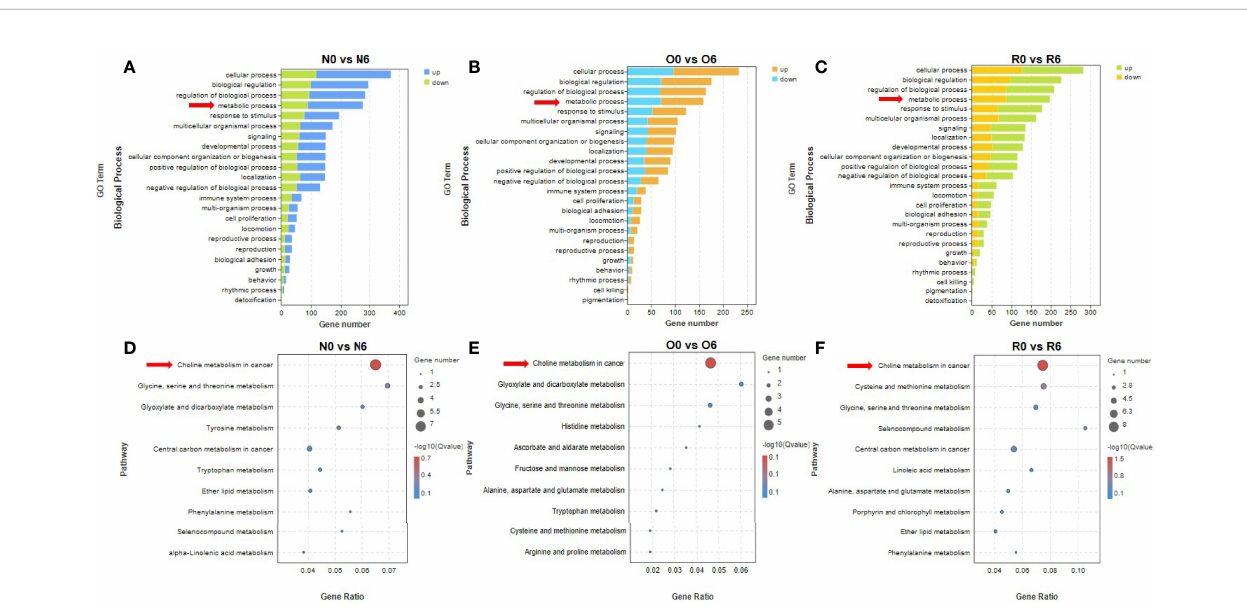
FIGURE 3 | The drug ef fi cacy mechanism of HHT was related to choline metabolism. Biological processes signi fi cantly affected in different cell lines with 10 nM HHT treatment for 6 hours (A, B) or HHT withdraw for 6 hours in the resistant line were found by GO enrichment analysis (C) . HHT was found to signi fi cantly affect metabolism-related signaling pathways by KEGG enrichment analysis (D – F)